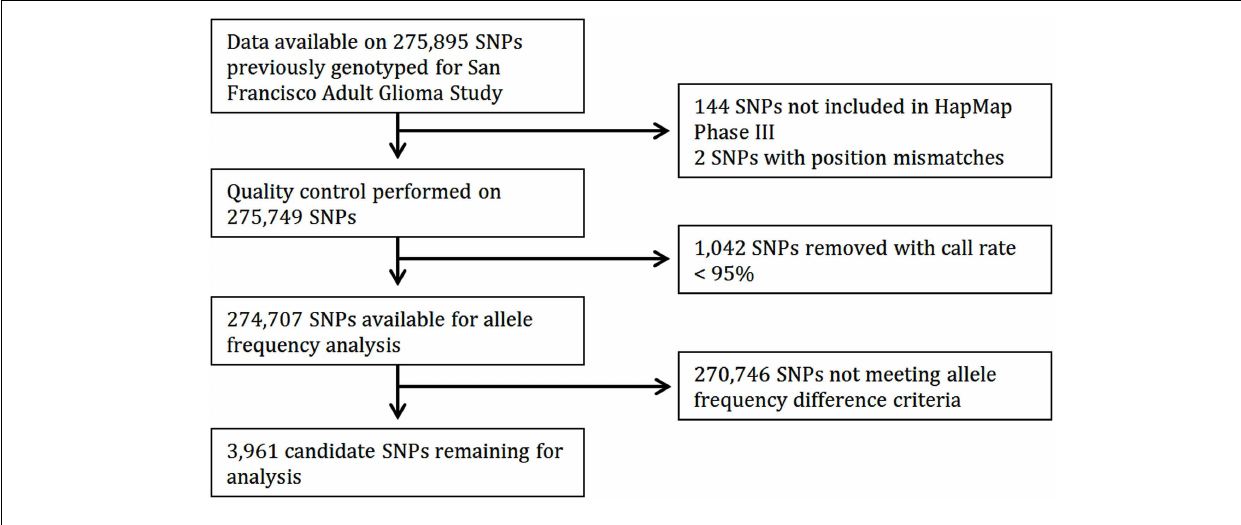
FIGURE 2 | Flow diagram of candidate SNP selection from HapMap.